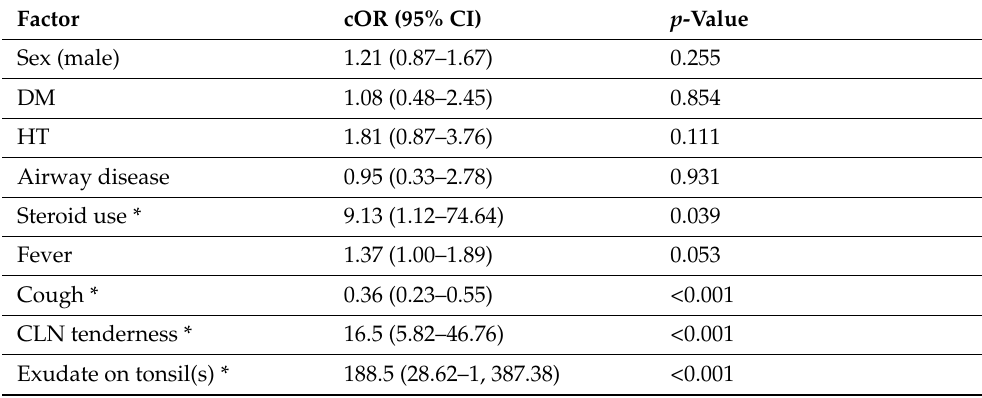
Table 3. Factors associated with antibiotic